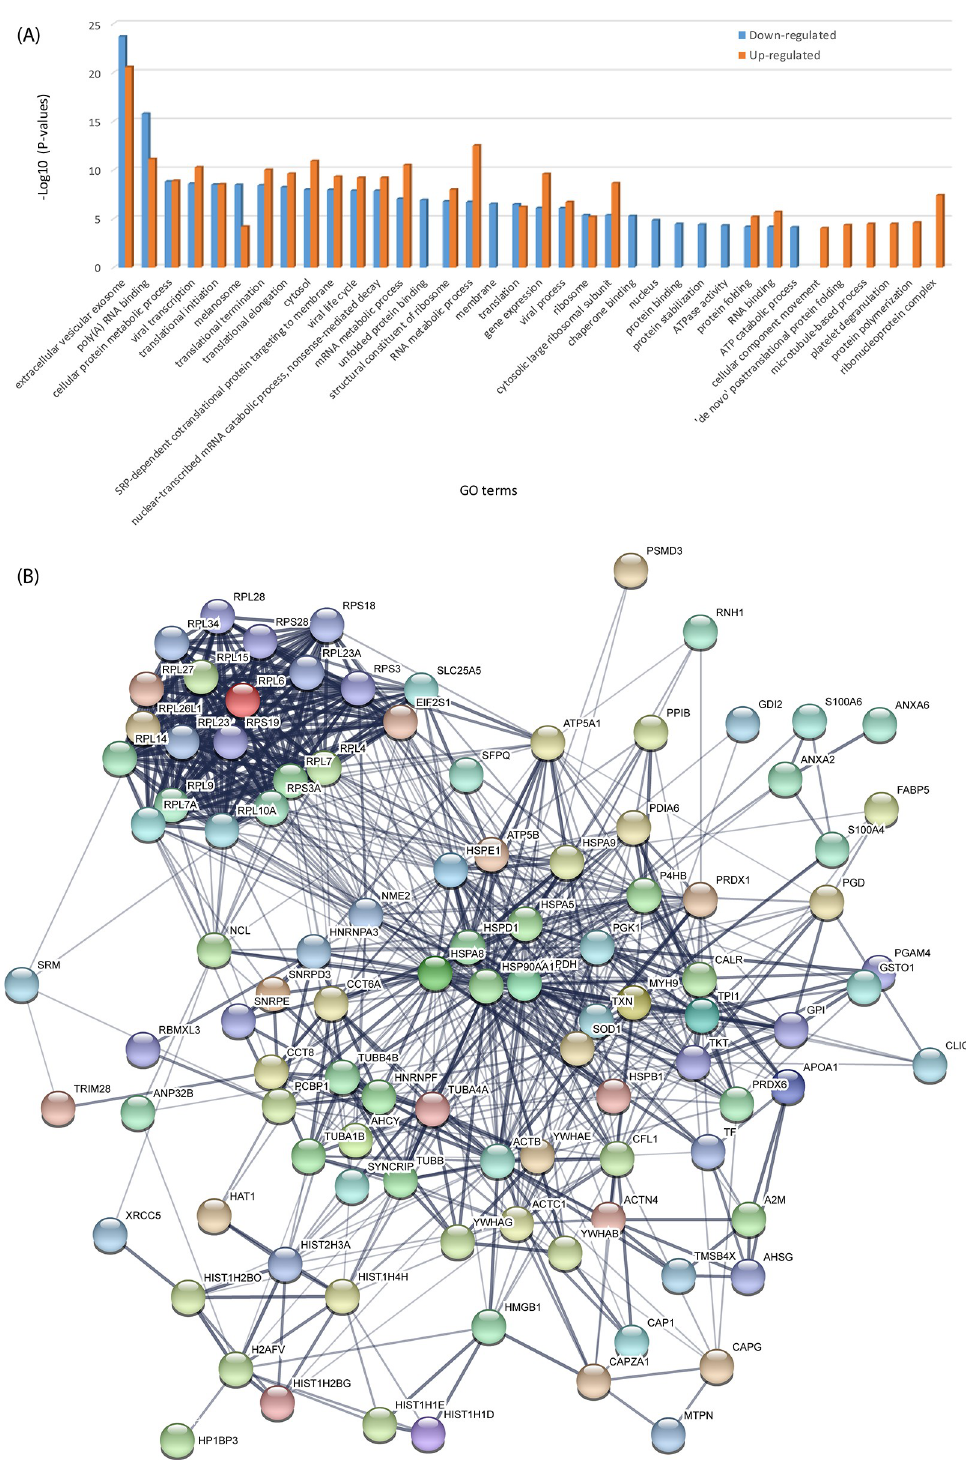
Fig 4. The gene ontology and protein-protein interaction (PPI) analysis of significantly regulated proteins identified in LPS+anti-IL10 antibody treated U937 cells by iTRAQ-labelled LC-MS/MS. (A) The GO terms enriched in significant up/down-regulated proteins; (B) The PPI network predicted based on significantly regulated proteins (see S3 Table for more details).